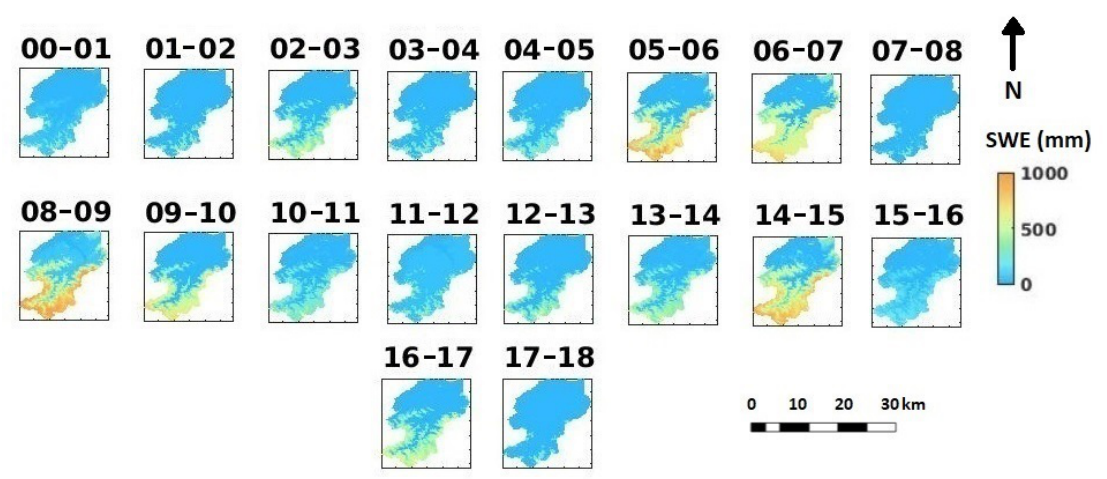
Figure 12. Maps of the simulated 1 April SWE for every year of the study